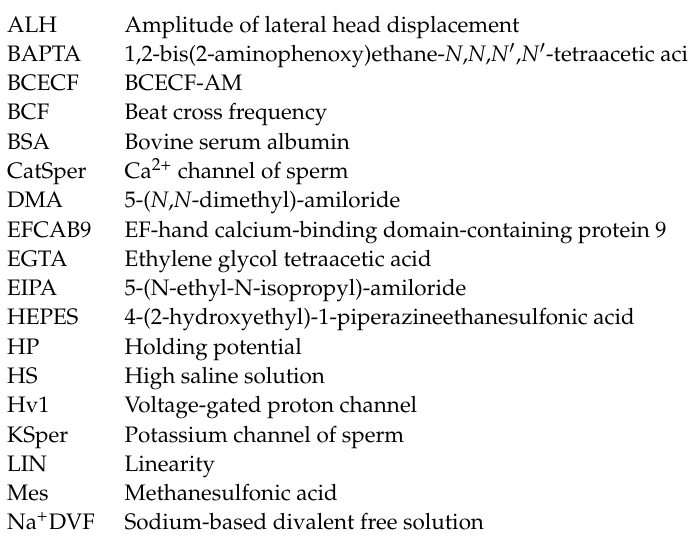
and commercially sNHE antibodies failed to inhibit CatSper